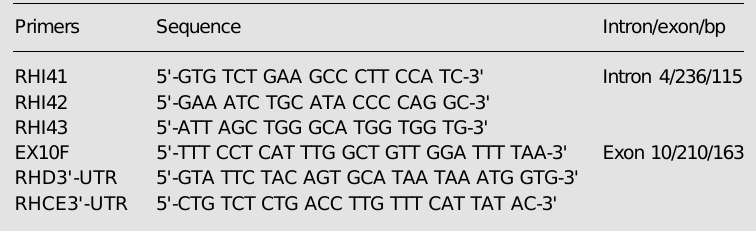
Table 1. Primers used for RHD genotyping.